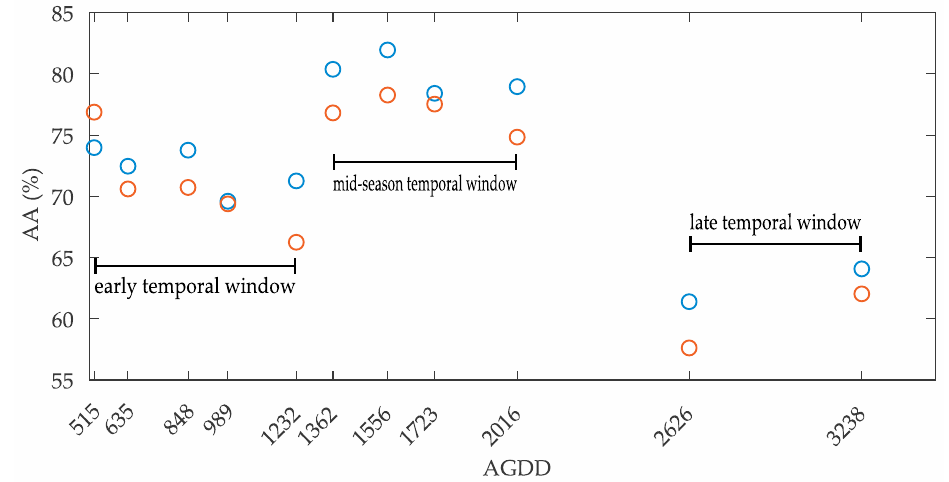
Figure 2. Average accuracy (AA) for all observation dates, represented as accumulated growing degree days (AGDD), for the NIR-RGB setting in blue and the RGB setting in red. The three temporal windows are indicated.